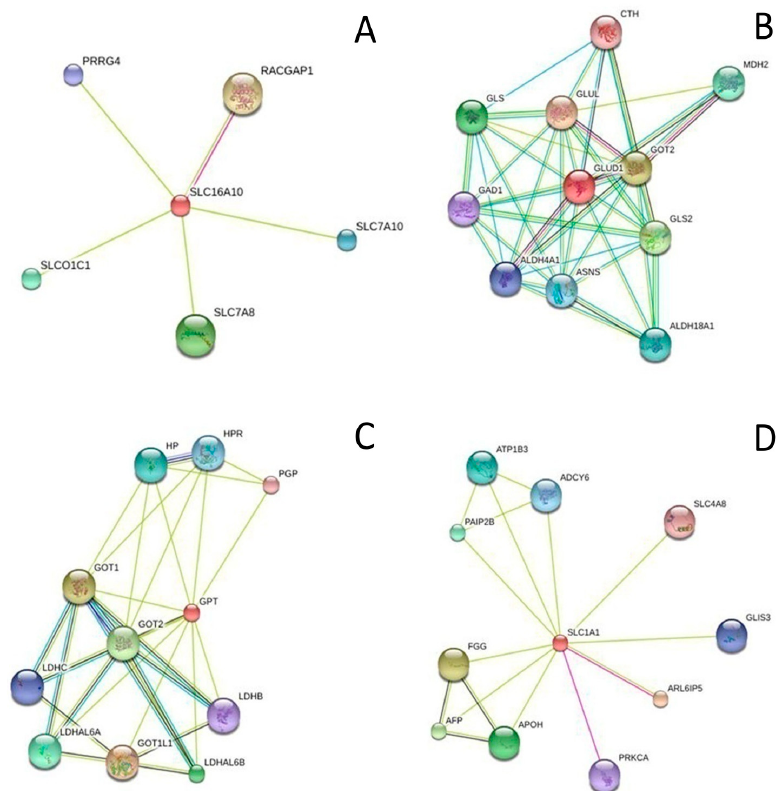
Figure 5. Functional interaction networks of SLC16A10 ( A ); GLUD1 ( B ); GPT ( C ) and SLC1A1 ( D ). The key enzymes (SLC16A10, GLUD1, GPT and SLC1A1) were collected and input into the STRING database to analyse the proteins that interacted with them. Only proteins with higher confidence were considered possible targets network for the metabolites. The protein was in turn docked into the protein targets. Each ligand-receptor pair would produce a MOE docking score, along with docking pose results, to represent the binding energy of this ligand-receptor complex.